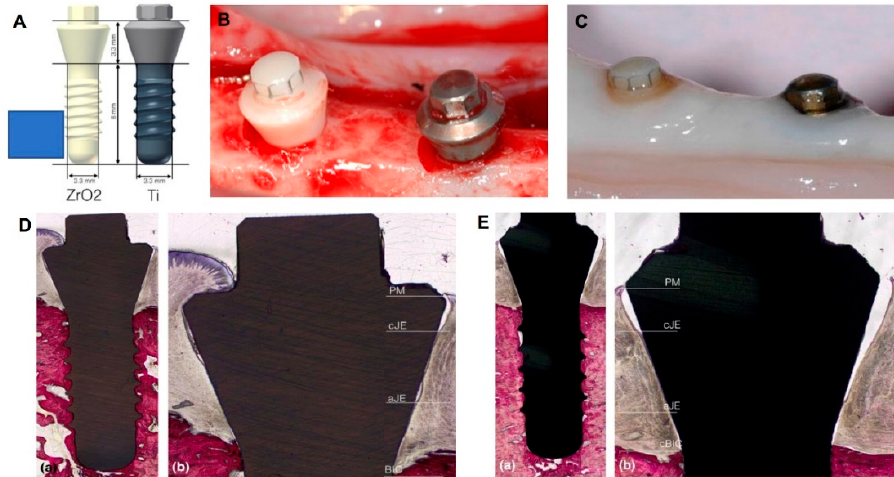
Figure 4. The soft and hard tissues histomorphological outcomes of ceramic and titanium